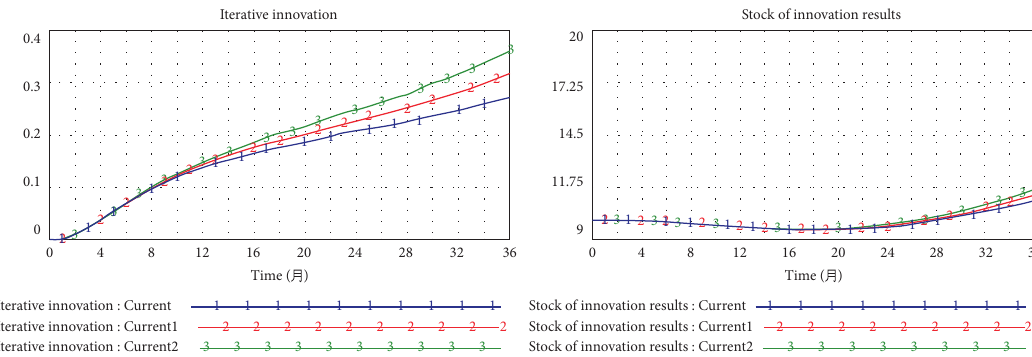
Figure 6: The impacts of domain knowledge searching on iterative innovation and stock of innovation